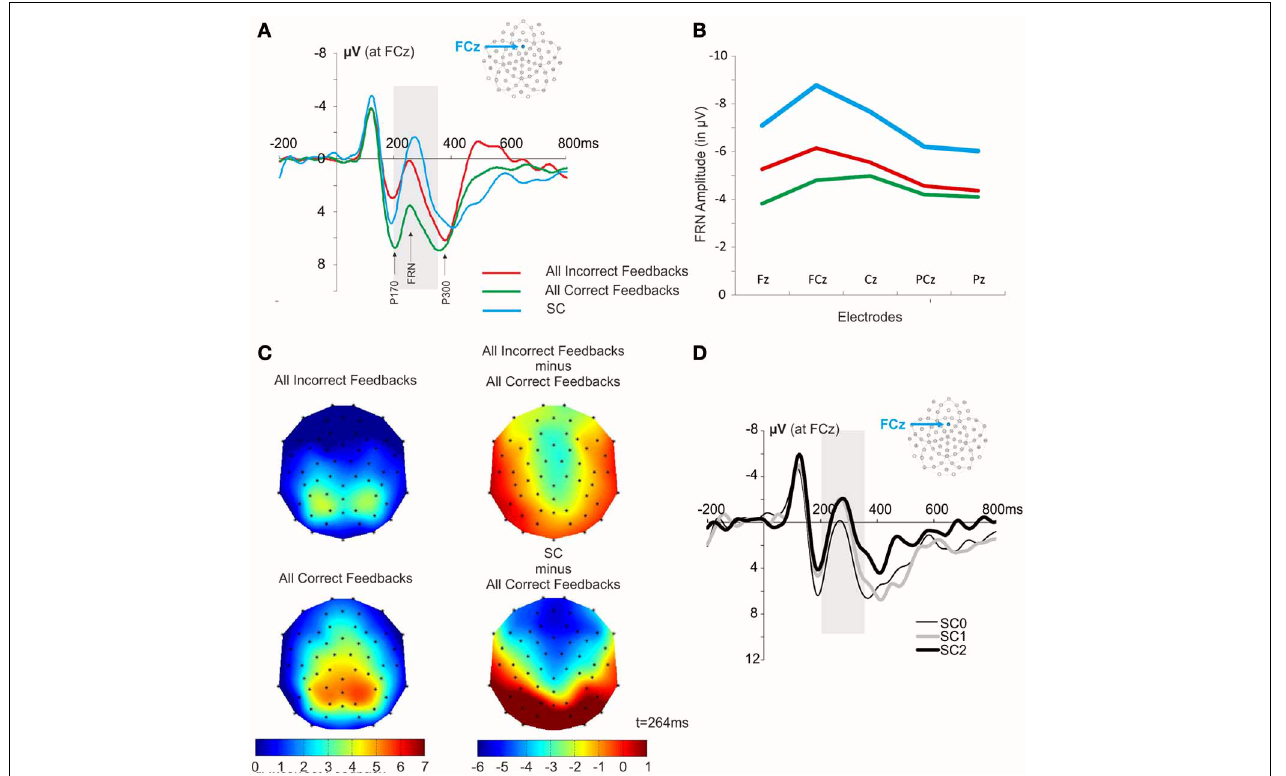
FIGURE 5 | FRN and scalp topography at the presentation of the SC and the feedback. (A) Waveforms elicited by all incorrect feedback, all correct feedback and by SC at FCz. The gray box is indicating the time windows of interest in which we measured the amplitude of FRN ( + 200 to + 350ms post feedback). (B) Amplitude of the FRN after correct feedback, incorrect feedback and SC measured at electrode Fz, FCz, Cz, PCz, and Pz. (C) Scalp topography obtained at the time of average FRN latency for the different feedbacks ( t = 264ms). Note that